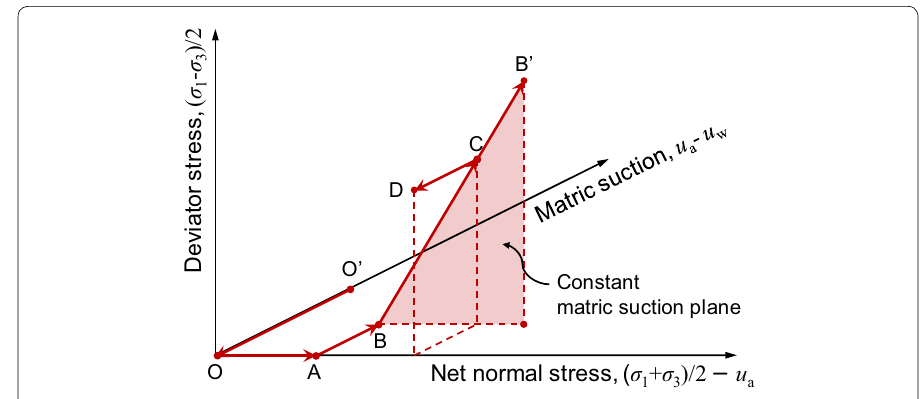
Fig. 8 Stress paths of soil specimen during triaxial shearing-infiltration test